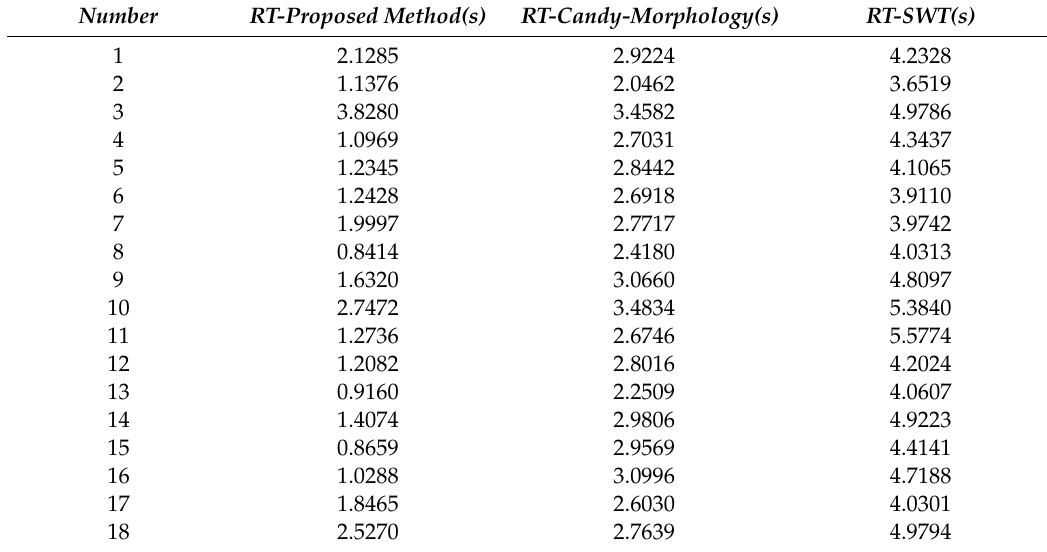
Table 2. Running time for expansion joints of all the images using three